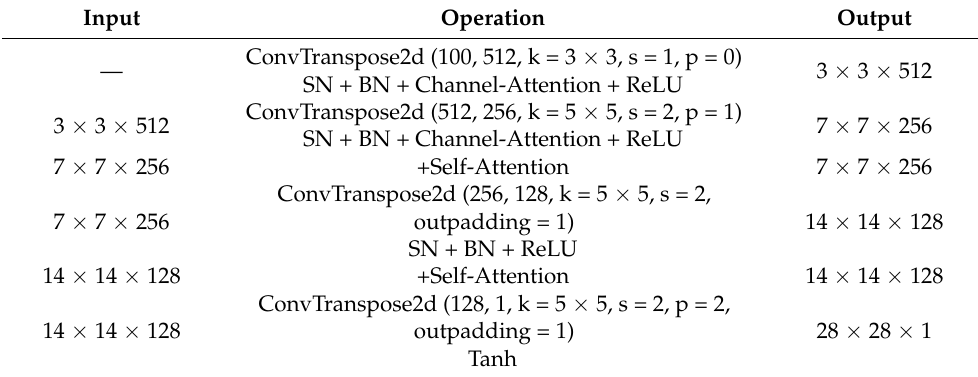
Table 5. The network structure of the generator in MNIST.